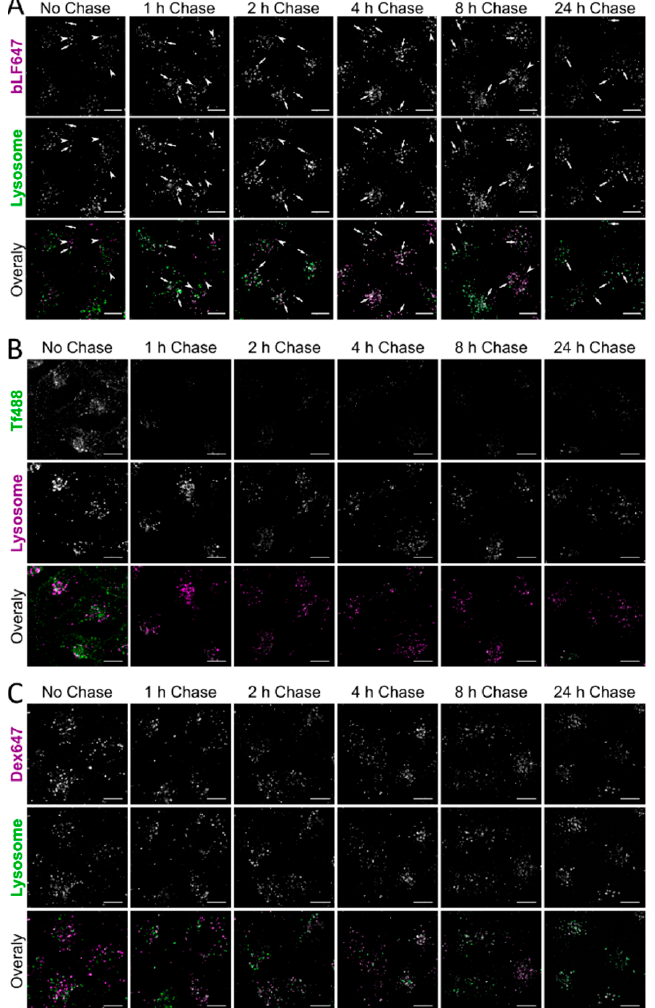
Figure 4. Trafficking of bLF647, Tf488, and Dex647 to lysosomes by confocal microscopy. Cells were incubated with 500 nM bLF647 ( A ), 20 nM Tf488 ( B ), or 100 µ g/mL Dex647 ( C ) for 1 h in SFM, washed in serum-containing medium, and incubated for the chase period before being washed and imaged by confocal microscopy. Lysosomes (green, middle row) were prelabelled using a pulse–chase protocol. Arrows represent endocytic structures with colocalised bLF and endolysosomal structures (white), arrow heads indicate bLF647 endocytic structures not colocalised with the lysosome. Scale bar = 10 µ m, representative images from three independent experiments quantified in Figure 5. See Supplementary Figures S2–S4 for uncropped